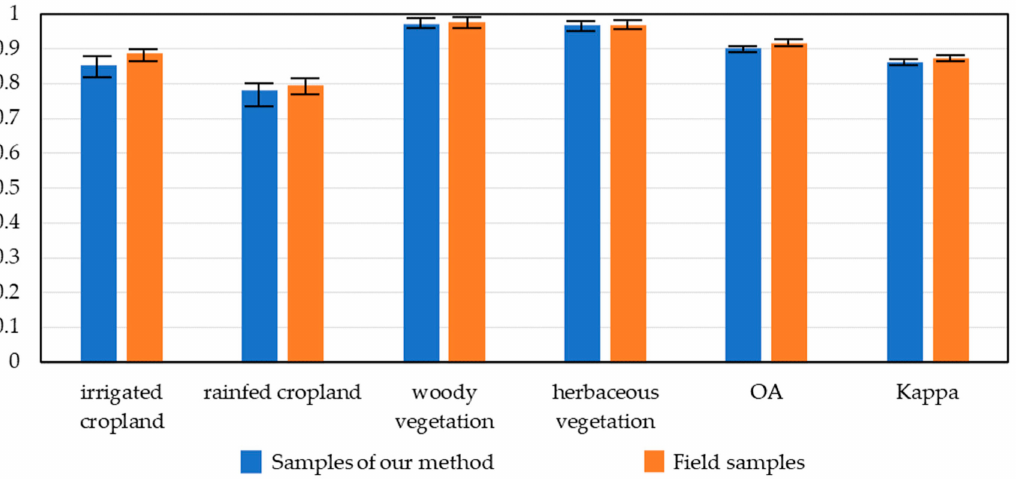
Figure 6. The mean of F1 score, overall accuracy, and kappa from 2019 to 2021. Error bars indicate the min and max intervals.